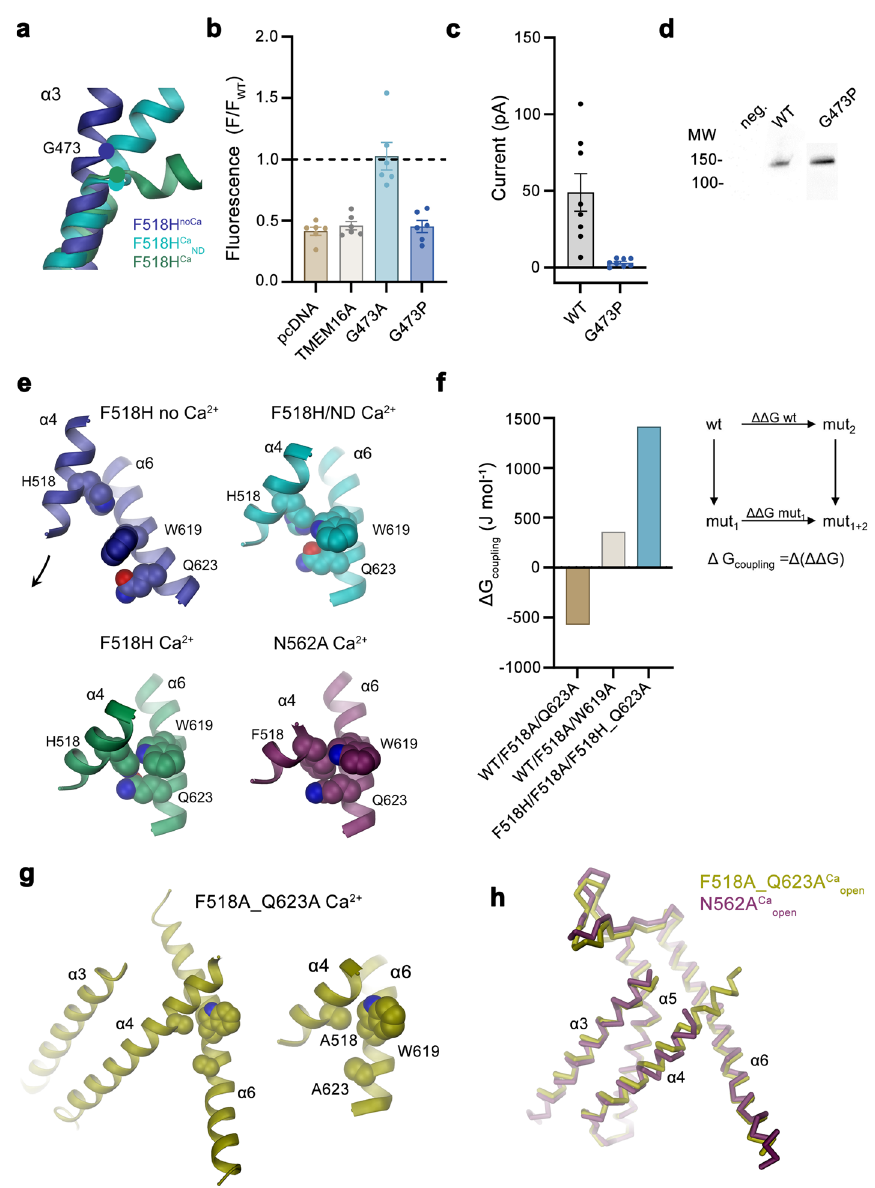
Fig.8|Functionalrelevanceofresiduesduringactivation.a Conformationof α 3 around the hinge residue Gly 473 (circle) in structures obtained for the mutant F518H. b Lipid transport activity of Gly 473 mutants quanti fi ed in a cellular scrambling assay. Data shows fl uorescence levels normalized to WT, at elevated Ca 2+ ,600safterapplicationofionomycin.DashedlineindicatesmeanvalueofWT. Bars show mean of six biological replicates (depicted as spheres), errors are s.e.m. c Current magnitudes of HEK293T cells expressing WT or G473P recorded in excised patches. Bars represent mean of individual experiments ( n =8), errors are s.e.m. d Surface expression of G473P. Anti-myc Western blot corresponds to bio- tinylated constructs pulled-down from HEK293T cells expressing myc-tagged WT or G473P after surface biotinylation. Samples are derived from the same